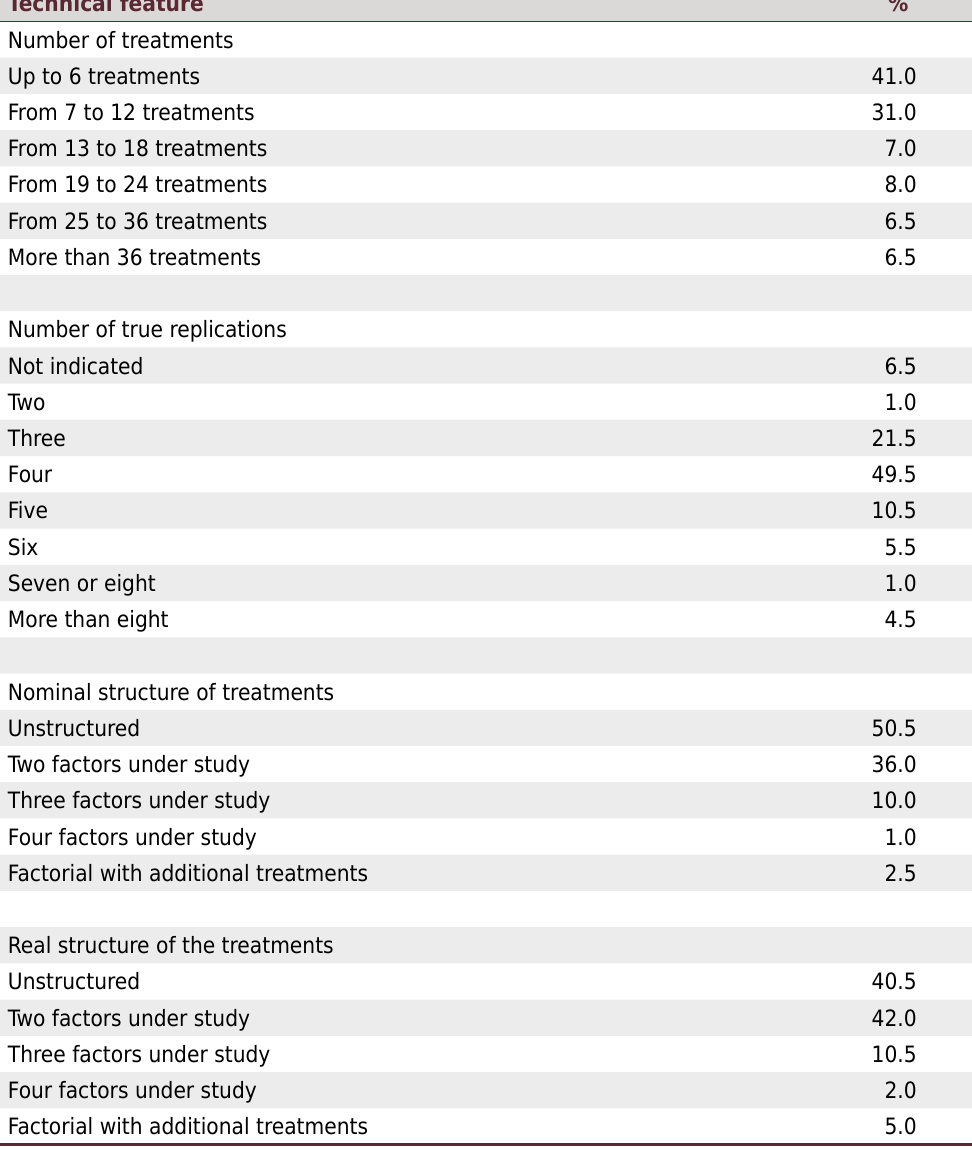
Table 2. Frequency of studies, in percentages of the total number of studies assessed, classified according to the characteristics of the experiments in soil science in Brazilian journals in relation to experimental size and the treatment